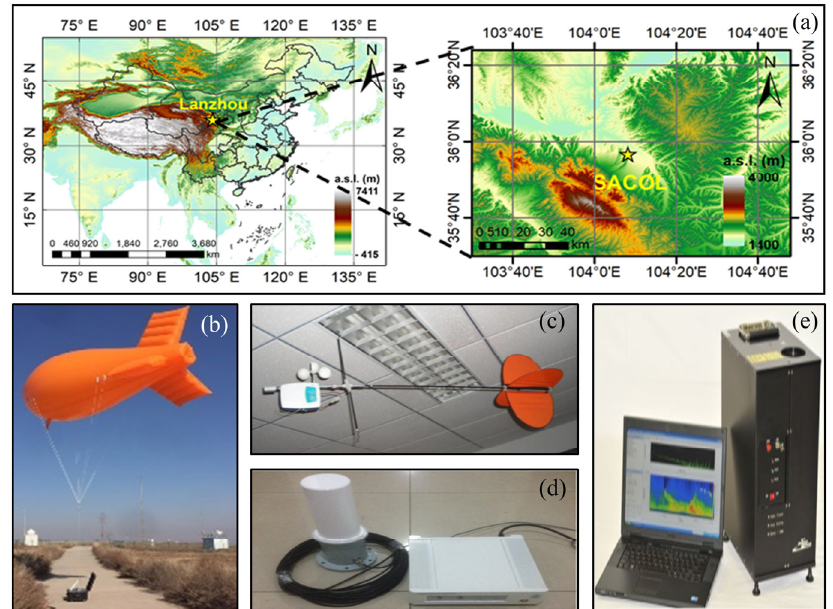
Figure 1. Observation site and instruments used: ( a ) local topography (The topographic data was the shuttle radar topography mission 3 (SRTM3) data from the National Aeronautics and Space Administration (NASA)), ( b ) tethered balloon, ( c ) radiosondes, ( d ) ground antenna of the sounding system, and ( e ) MiniMPL lidar.